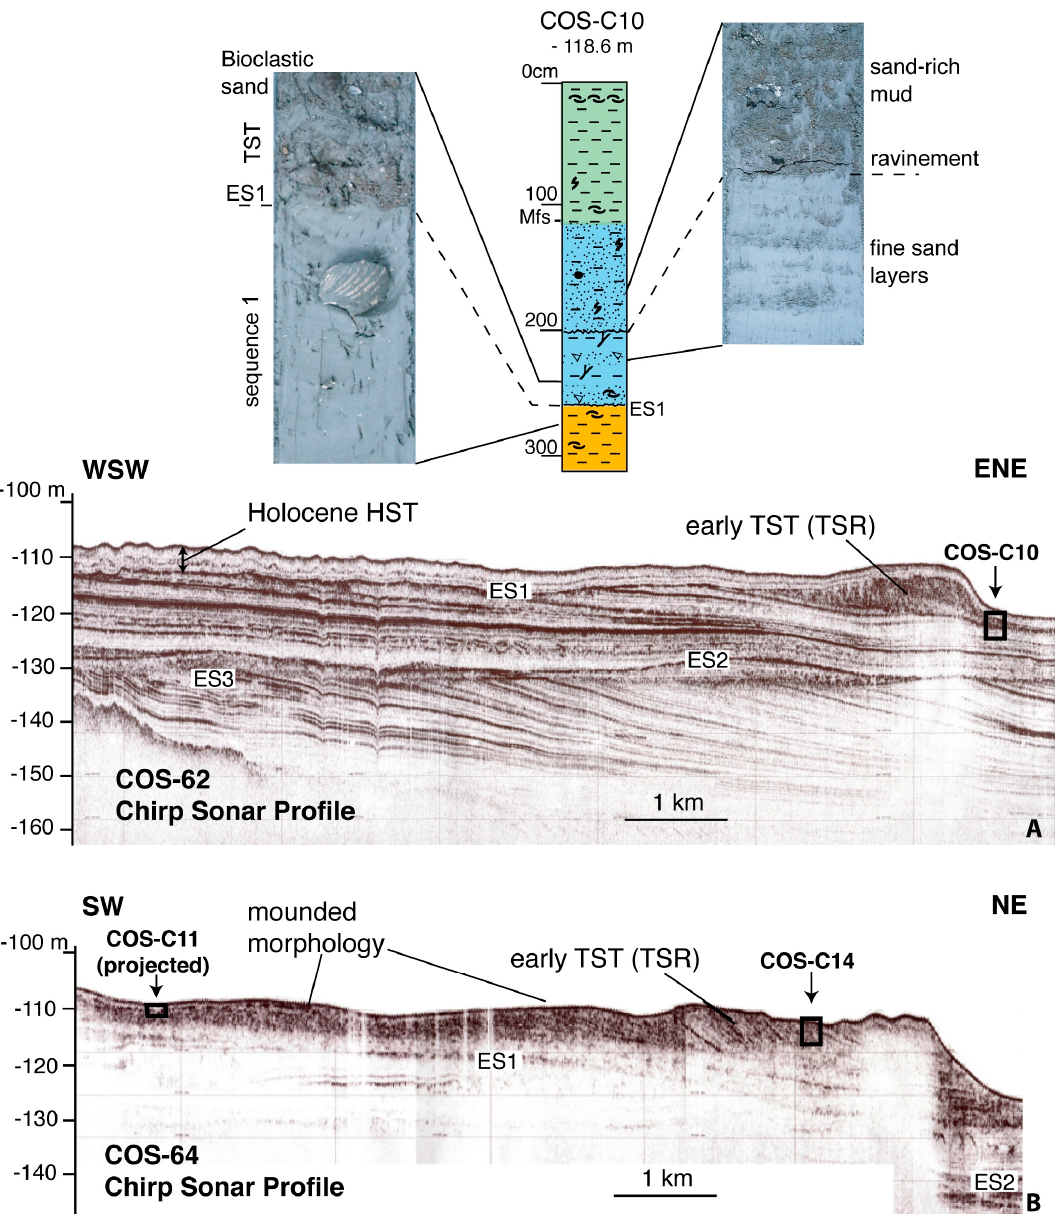
Figure 8. Seismic profiles (location in Figures 1 and 6) showing the ridge-like shape and internal progradational geometry of TSR from the NE-Gargano (( A ) modified from [56]) and E-Gargano depocenters ( B ). Note the abrupt pinch-out of the NE-Gargano TSR compared to the mounded deposits extending landward (SW) of the E-Gargano shelf edge clinoform. Position of cores COS-C10 (with details of cored TSR interval) and COS-C14 is reported (see also Figure 7).